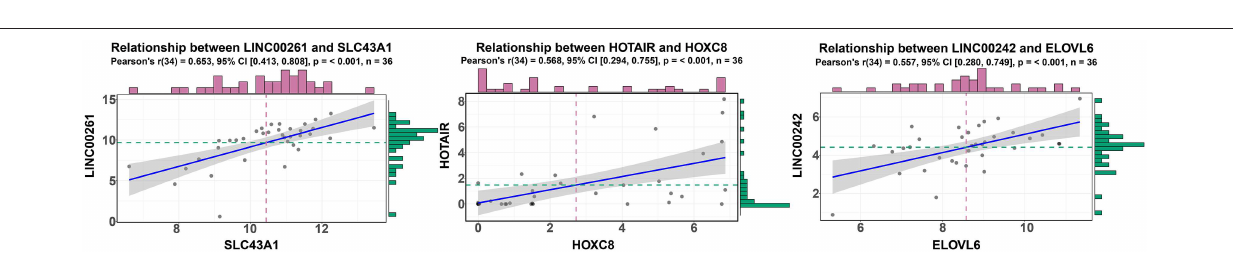
FIGURE 5 | Regression analysis between the expression levels of DElncRNAs and DEmRNAs targeted by hsa-miR-211 in the ceRNA network (showing the top three correlation coefficients). The horizontal axis denotes the expression of the DEmRNAs, and the vertical axis represents the expression of the DElncRNAs. The upper and right edges are histograms of gene